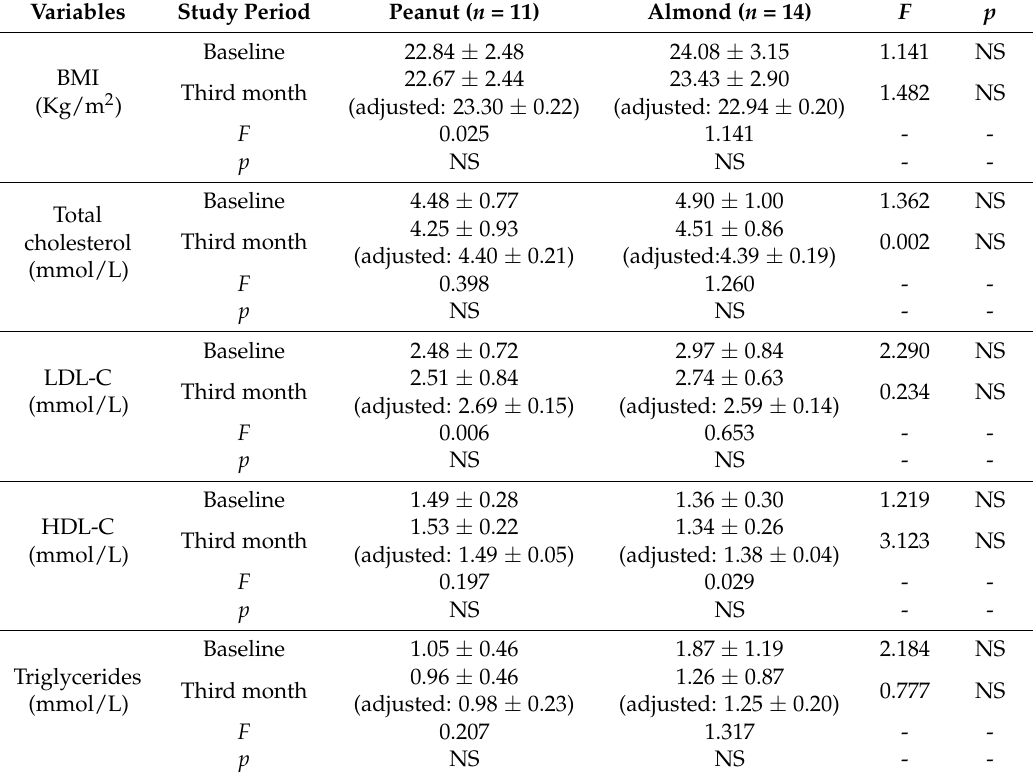
Table 6. Comparison of other cardio-metabolic indicators between the two